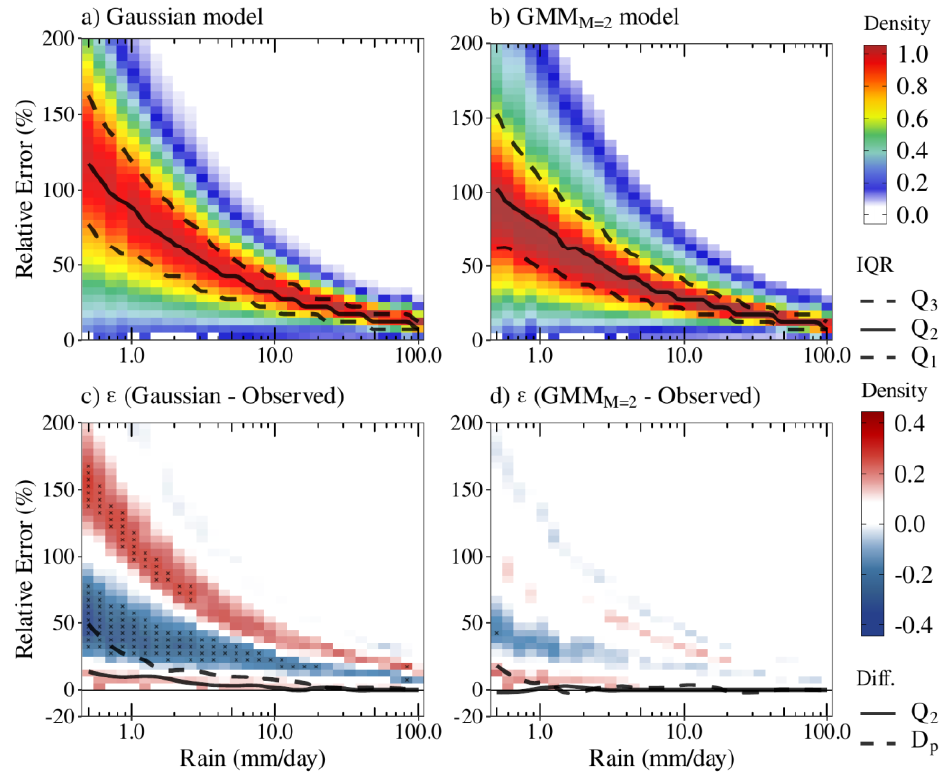
Figure 8. Density scatterplot of the ( a ) Gaussian and the ( b ) GMM (with M = 2) models and its respective residuals ( c , d ) in representing the relative error distributions ( y -axis, in %) as a function of the precipitation ( x -axis, in mm day −1 ) for the error sampling (by TAPEER1.5 product), during the JJA of 2014 and over ocean surfaces (between 35° N/S global zones). Black crosses mean the residual values above/below the ±0.2 density values. Solid and dashed black lines in c-d correspond to the differences between the model and the observed median (Q 2 ) and the density peaks (D P ), respectively.